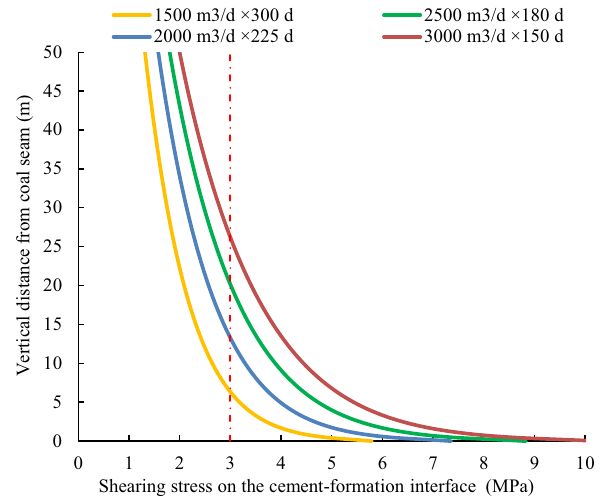
Fig. 6 Shearing stress on the cement-formation interface under vari- ous CO 2 injecting rates with same injection amount